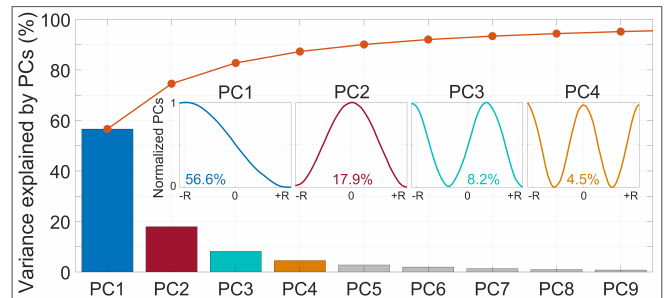
Figure 6. Principal components of the profiles and the total variance of the data explained by each principal component.